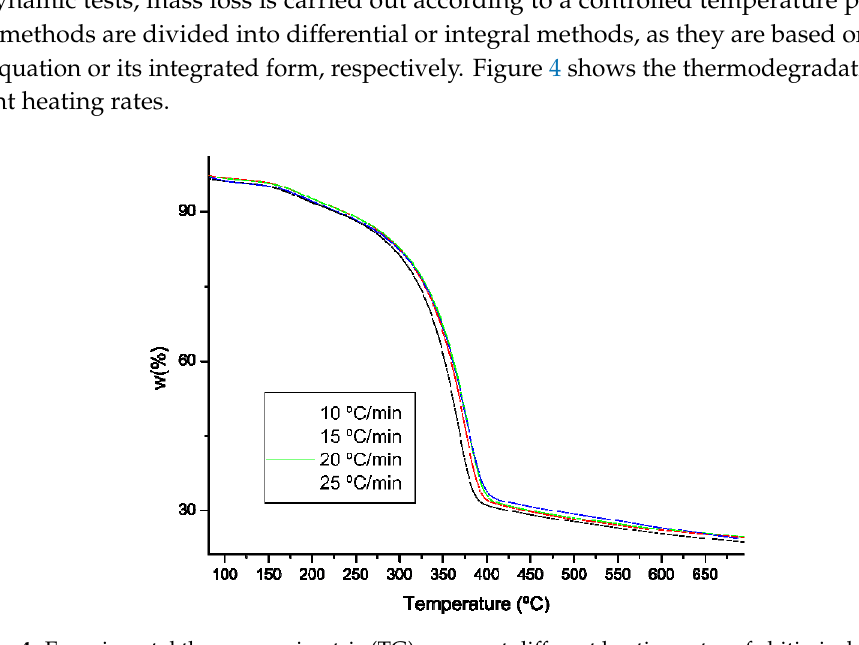
Figure 4. Experimental thermogravimetric (TG) curves at different heating rates of chitin isolated from Vespa velutina .